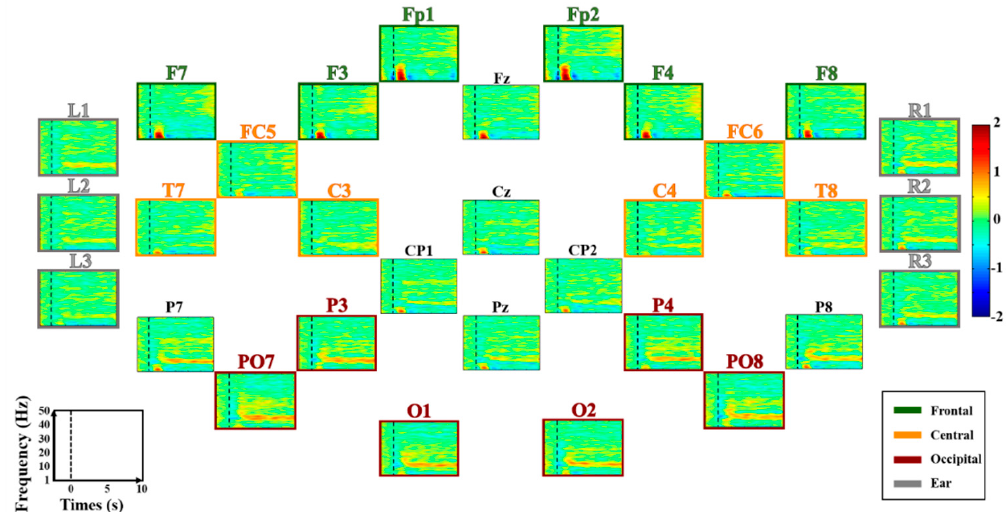
Figure 5. Grand average ERD/ERS maps of all electrodes during LC. The four regions of interest (ROIs), frontal, central, occipital, and ear area, are denoted by four different colored lines and titles for each map (green, orange, red, and gray), respectively. The x- and y-axis of each map indicate the task time from − 2–10 s based on task onset (t = 0 s), and the frequency band ranging from 1 to 50 Hz, respectively. ERD and ERS are presented in blue and red, respectively. Note that scalp- and ear-EEG are independently re-referenced using a CAR and a modified CAR, respectively.